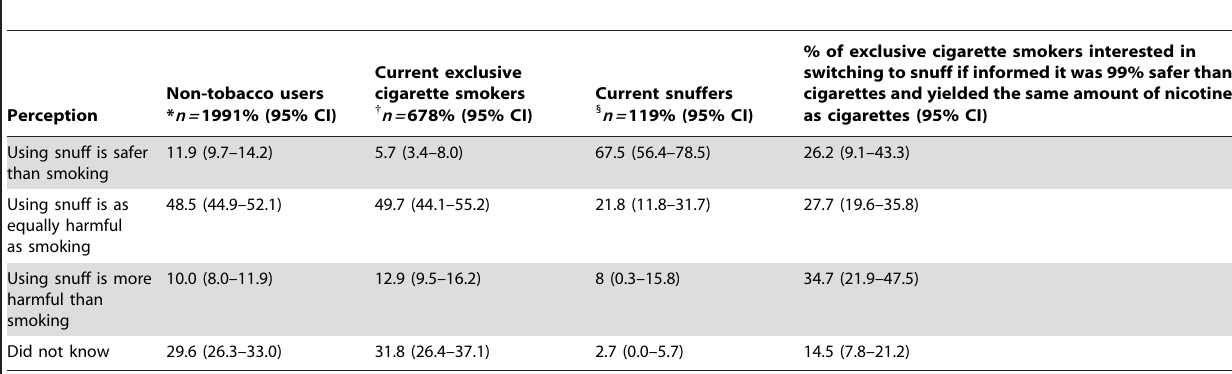
Table 3. Comparative risk perception between non users of tobacco, current cigarette smokers and current snuffers, South African Social Attitudes Survey,